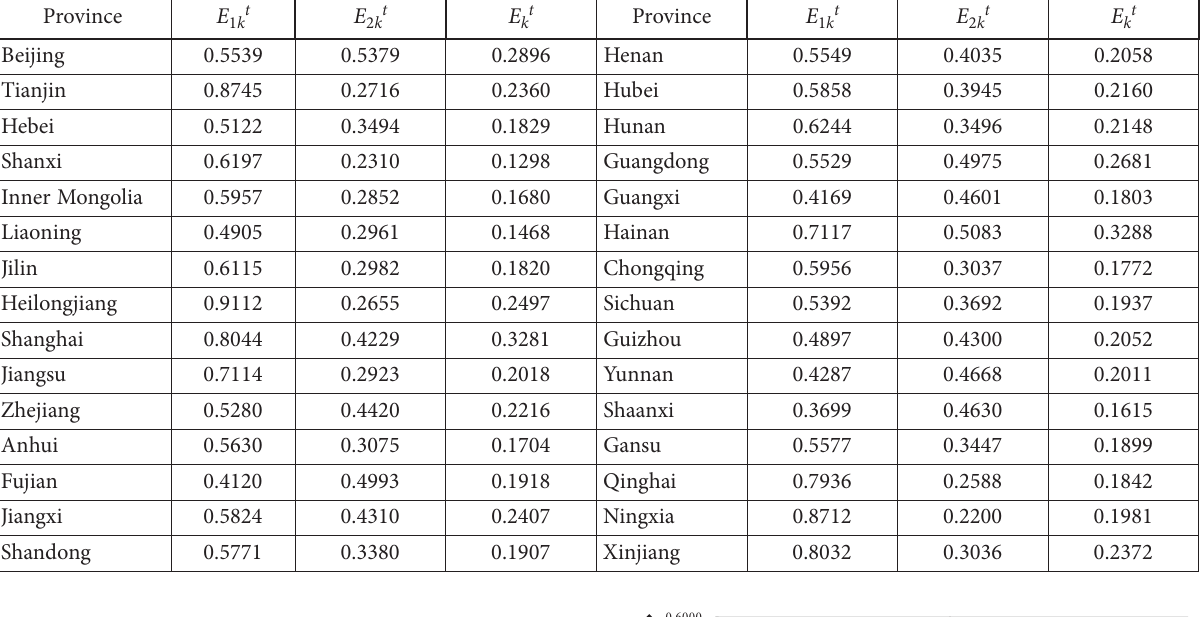
Table 5. The average provincial multi-period two-stage efficiency and its decompositions Province